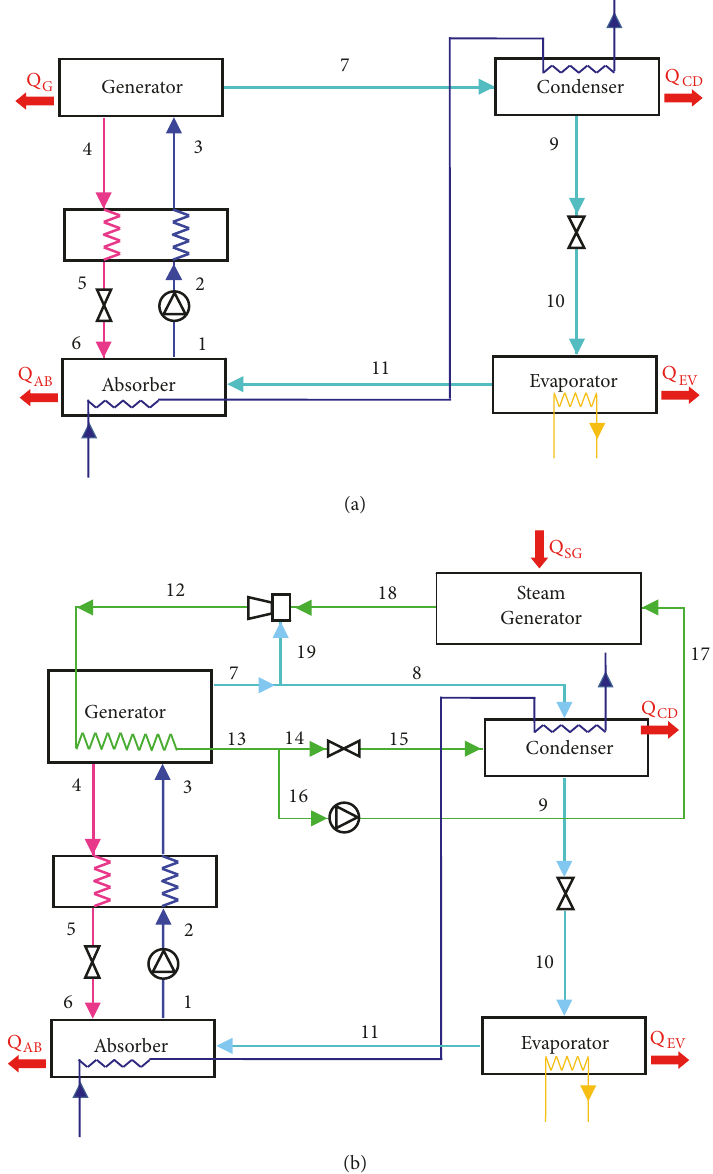
Figure 1: Single-effect absorption system: (a) conventional; (b) hybrid,